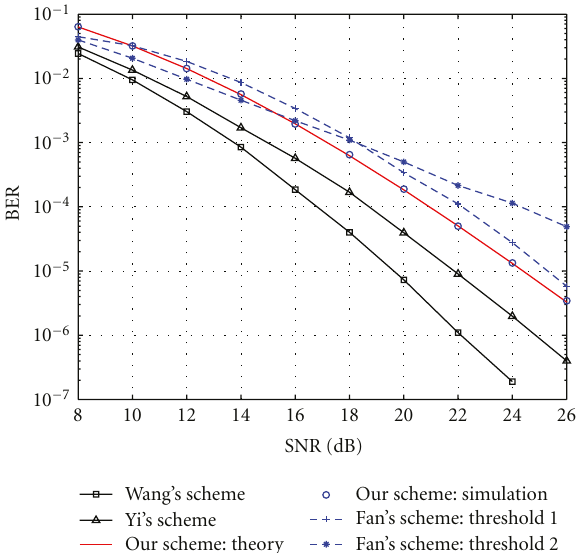
Figure 2: BER performance comparison for di ff erent SNR thresh- olds when R = 3: with the direct link.